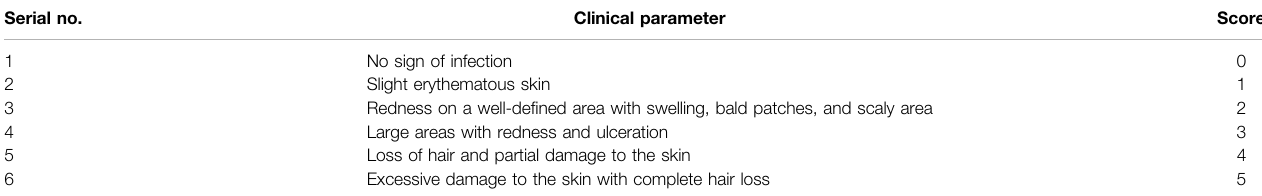
TABLE 4 | Clinical parameters and therapeutic ef fi cacy. Serial